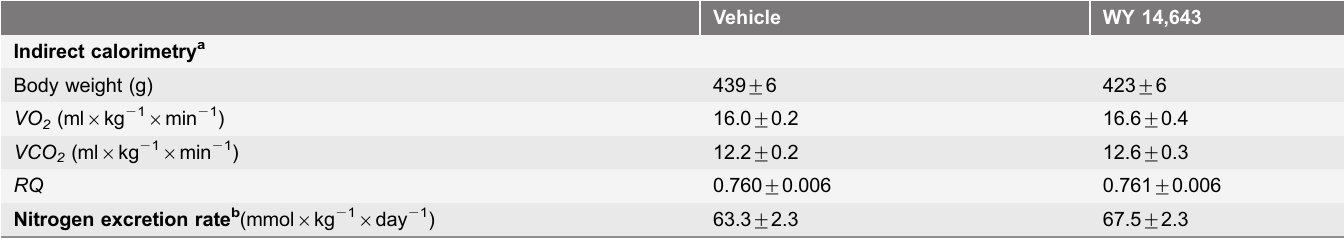
Table 2. Indirect calorimetry and urinary nitrogen excretion.